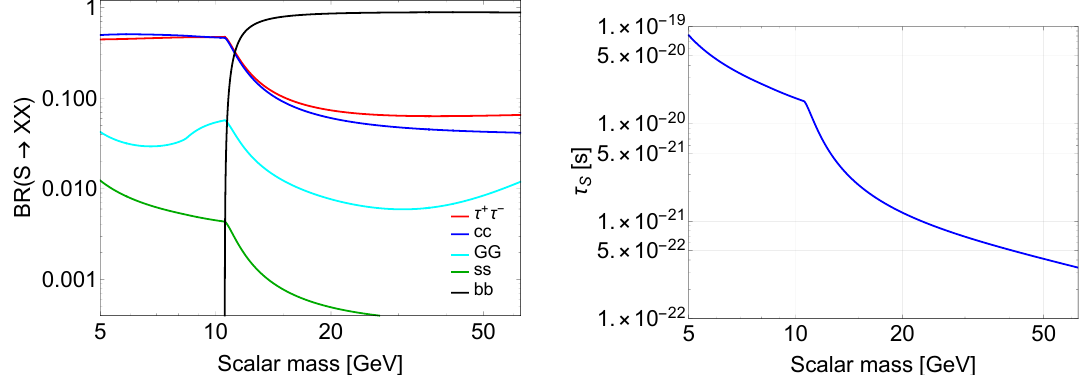
Figure 1 . Left panel: branching ratios of the decays of a scalar S as a function of its mass. We use perturbative decays into quarks and gluons (see [10] for details). Right panel: the lifetime of a scalar S as a function of its mass for the mixing angle (cid:18) 2 = 1. The lifetime is obtained using